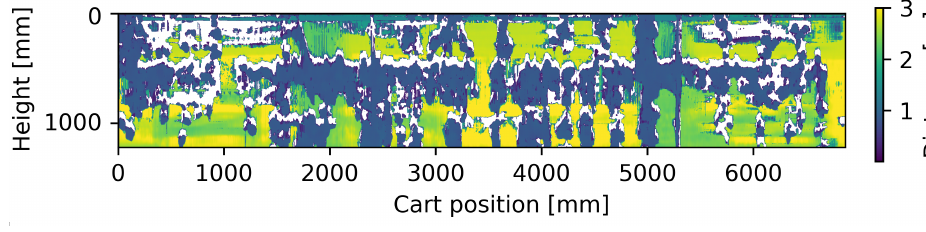
Figure 8. Collected data with an RGB-D camera.